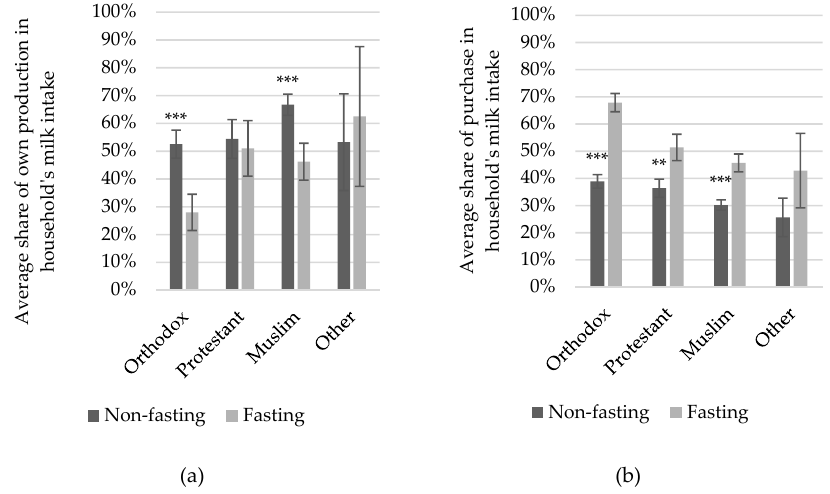
Figure 2. ( a ) Average share of home production and ( b ) purchase in total milk intake among milk-consuming religious households during Orthodox fasting and non-fasting; with confidence intervals drawn at α = 0.05; *** and ** represent statistical significance at a probability of less than 1% and 5%, respectively.